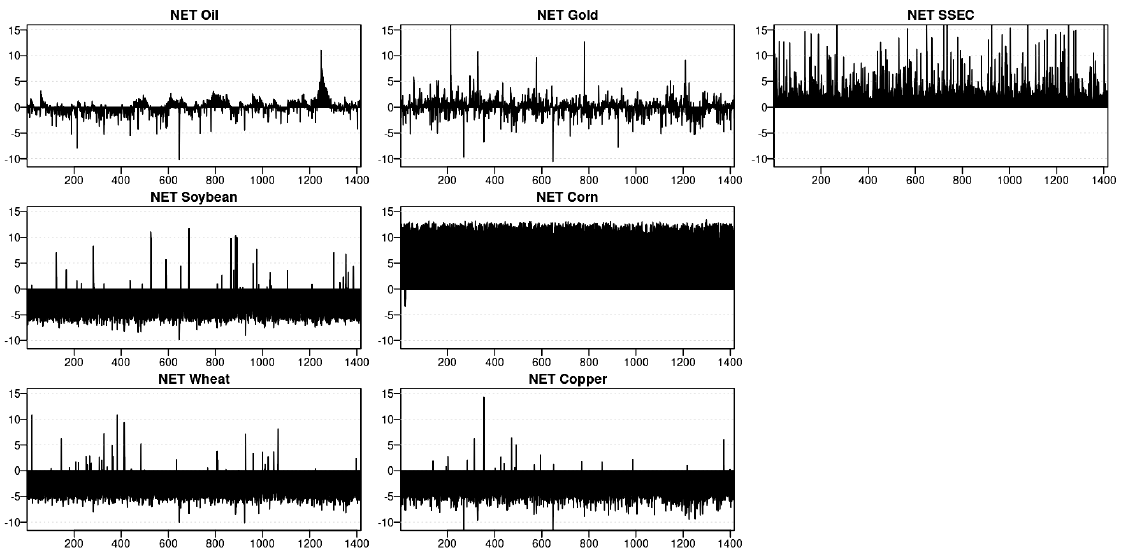
Figure 3. Net directional